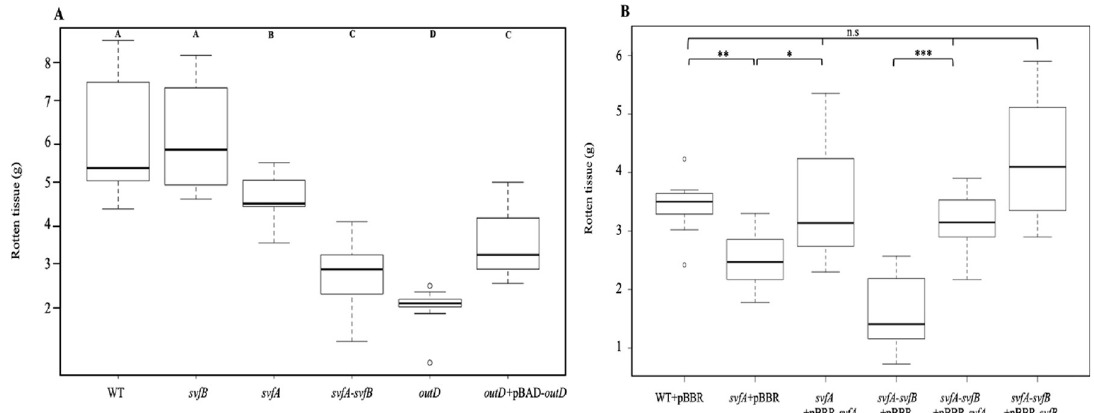
Fig 2. Virulence of svfA and svfB mutants. A. Potatoes (n = 9) were infected with the wild type strain, and the svfA , the svfB , the svfA svfB , the outD mutant and the outD complemented strain. Rotten tissue was weighed after 48 h. Statistical tests were performed using the Wilcoxon-Mann-Whitney test. The p -value were compared with an alpha risk of 4%. There is significant difference (p < 0.04) between A, B, C and D. B. Complementation of the svfA and the svfA svfB mutants. Potatoes (n = 9) were infected with the wild type strain, the svfA or the svfA svfB mutants containing the empty plasmid pBBR-MCS3 or the plasmid bearing svfA or svfB . Rotten tissue was weighed after 48h. Statistical tests were performed using the Wilcoxon-Mann-Whitney test. The p -value were compared with an alpha risk of 4%. p < 0.001 = ��� , p < 0.005 = �� , p < 0.01 = �